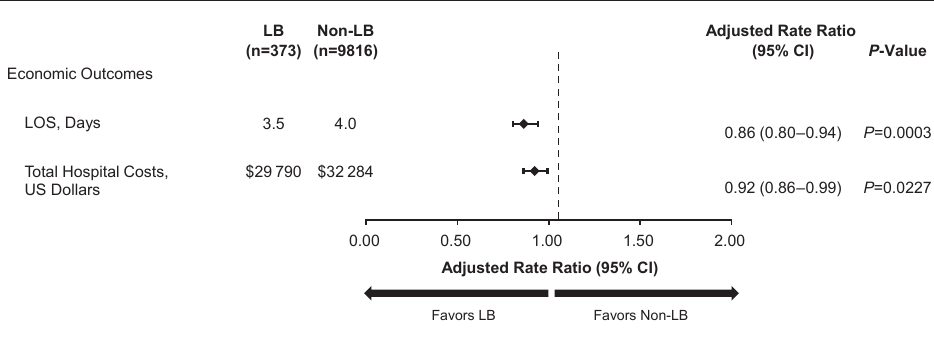
Figure 3. Adjusted Economic Outcomes After Primary Spine Surgery in Pediatric